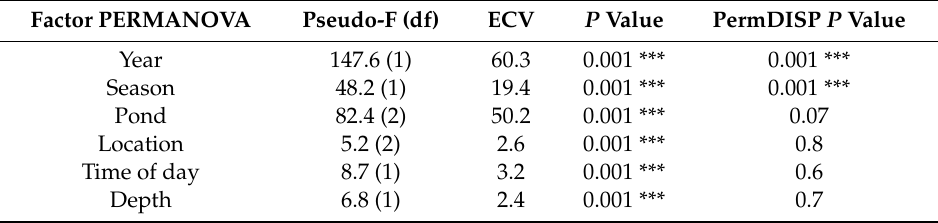
Table A2. A. PERMANOVA analysis testing the differences in the Firmicutes phylum between year (2012, 2013), season (early wet and dry), pond number (P1, P2 and P5), location within the ponds